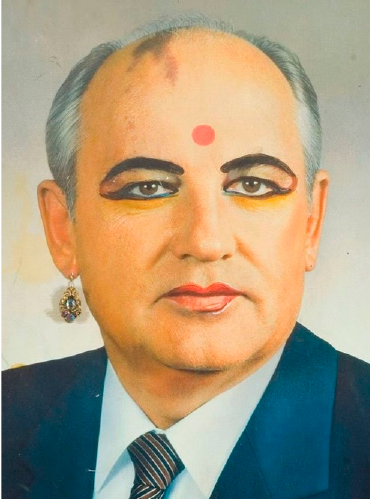
Figure 1. Vlad Mamyshev-Monroe. “M.S. Gorbachev” (1989). https://vmmf.org/series/view?id=47 (accessed on 8 September 2022).